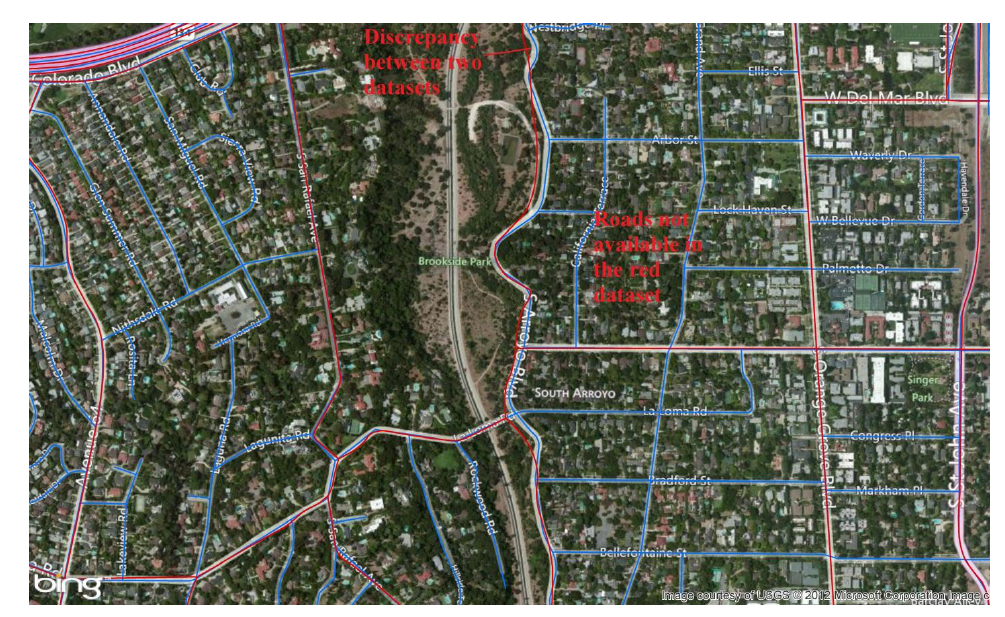
Figure 2. The discrepancy between Southern California Association of Governments (SCAG) data (red) and Topologically Integrated Geographic Encoding and Referencing (TIGER) data